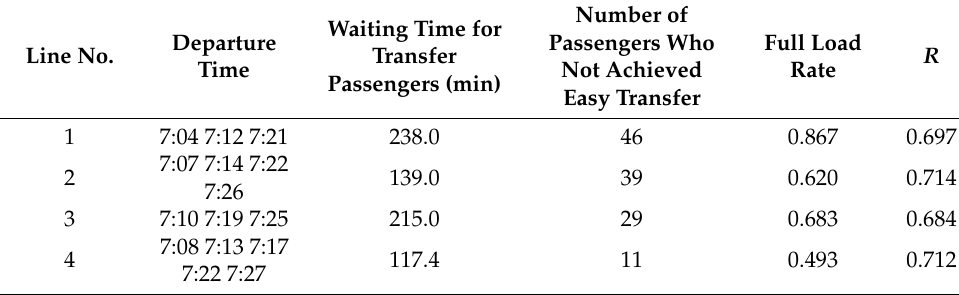
Table 5. The most satisfactory operation schedule.